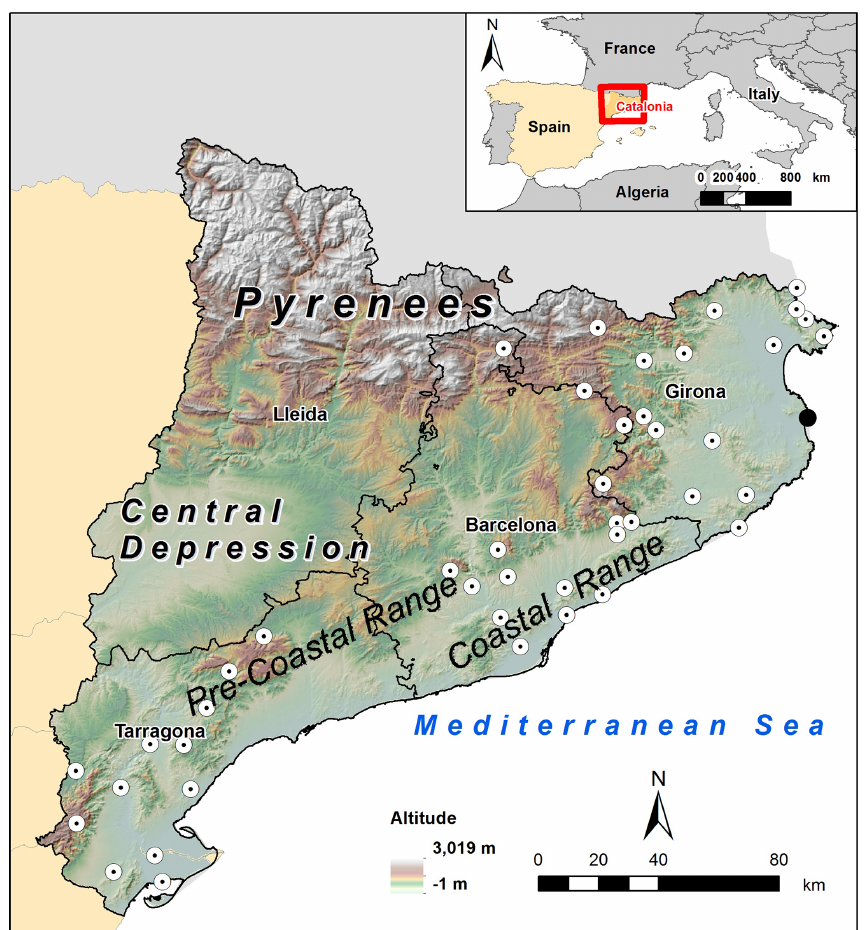
Figure 1. Location of Catalonia (NE Spain) within Europe – altitude and provinces. The white dots indicate the 43 different weather stations that have recorded the highest precipitation amount during an extreme torrential event at least once in Catalonia during the 1951–2016 study period. The black dot indicates the location of the sea temperature series. Base map provided by the Cartographic and Geological Institute of